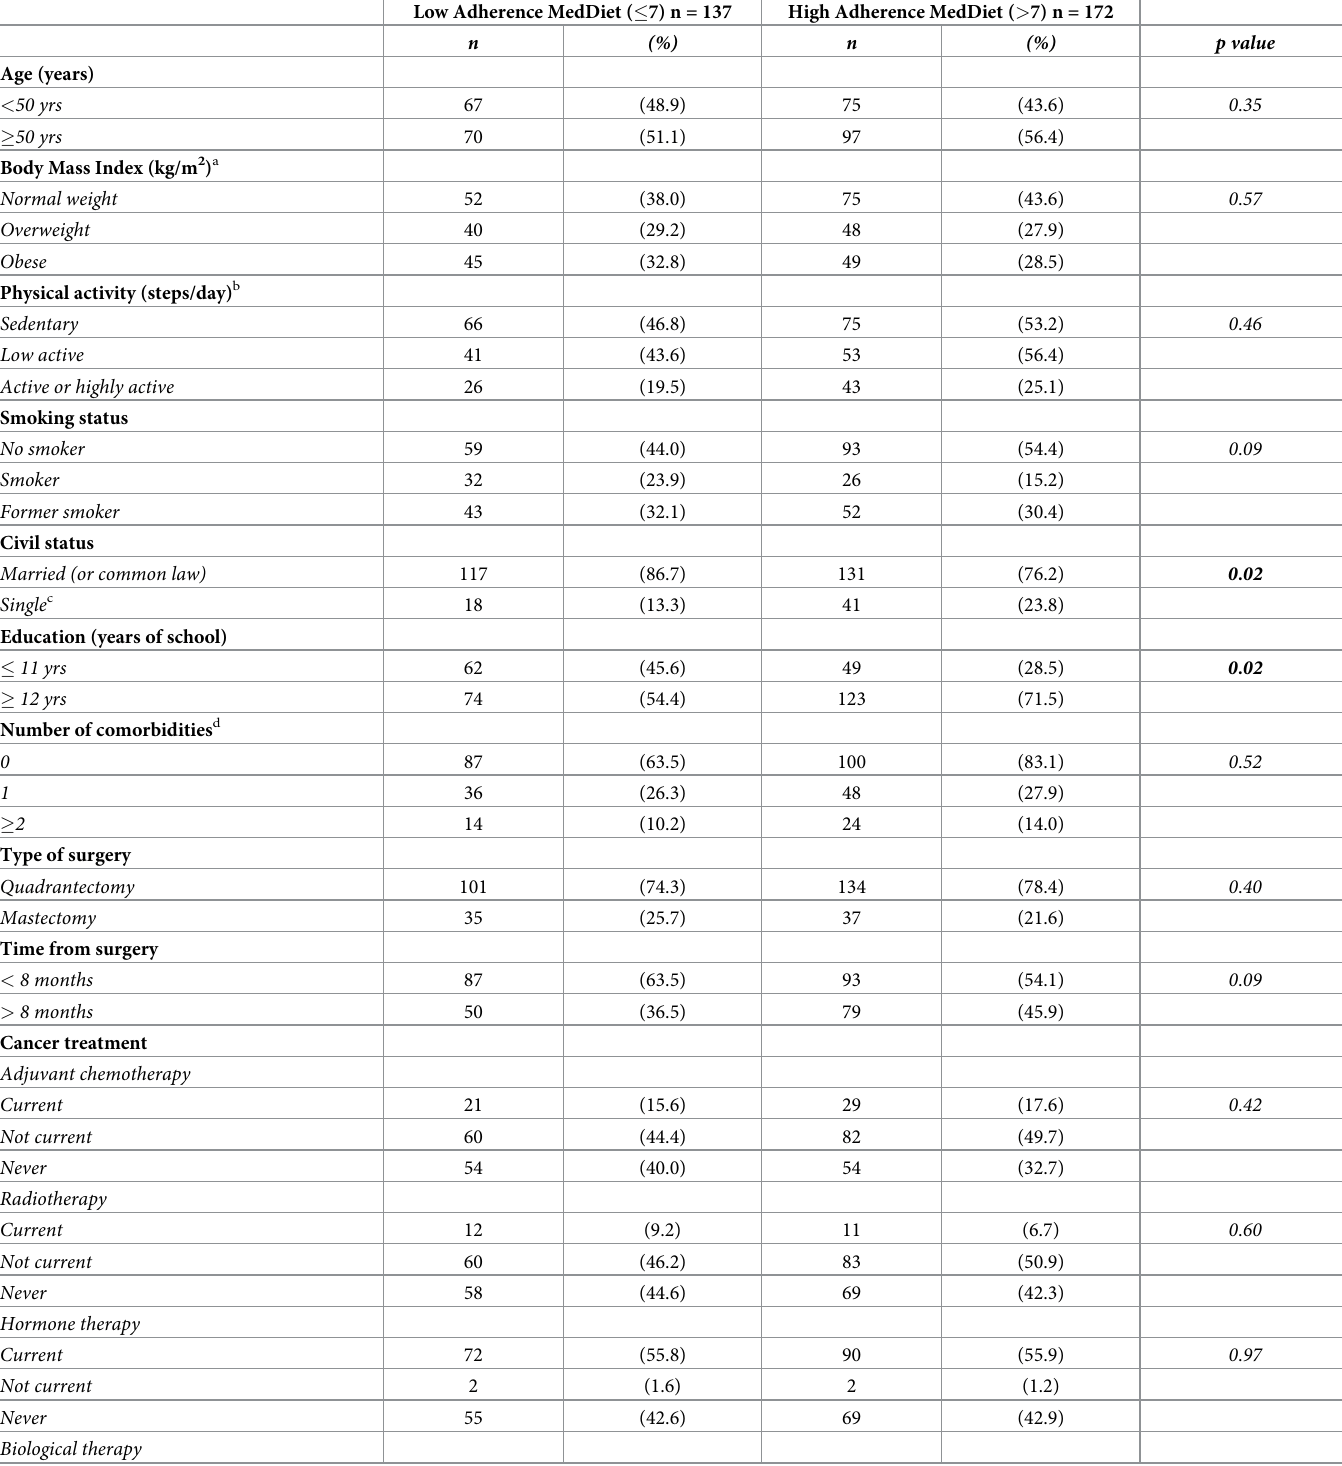
Table 2. Baseline characteristics of the participants (n = 309) according to baseline categories of adherence to Mediterranean Diet (MedDiet) assessed by PRE- DIMED 14-item